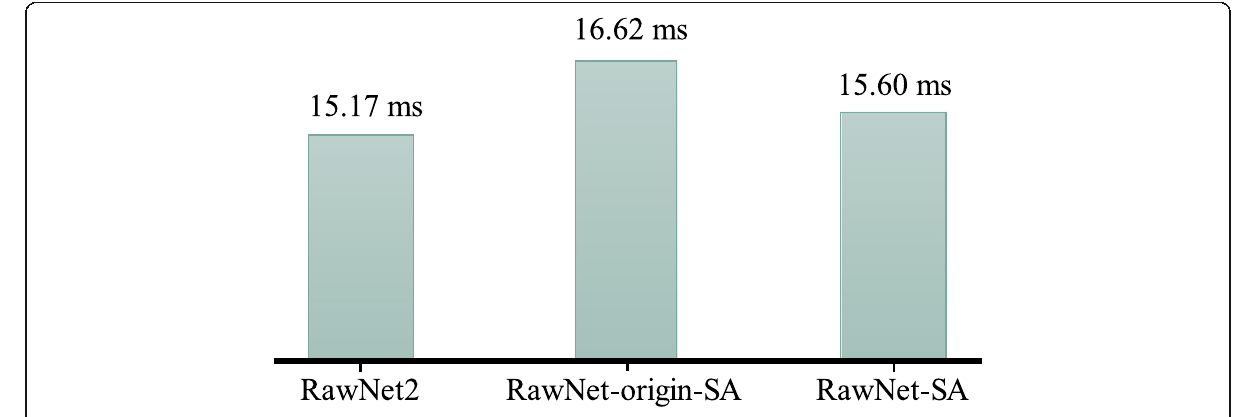
Fig. 9 Inference speed of different